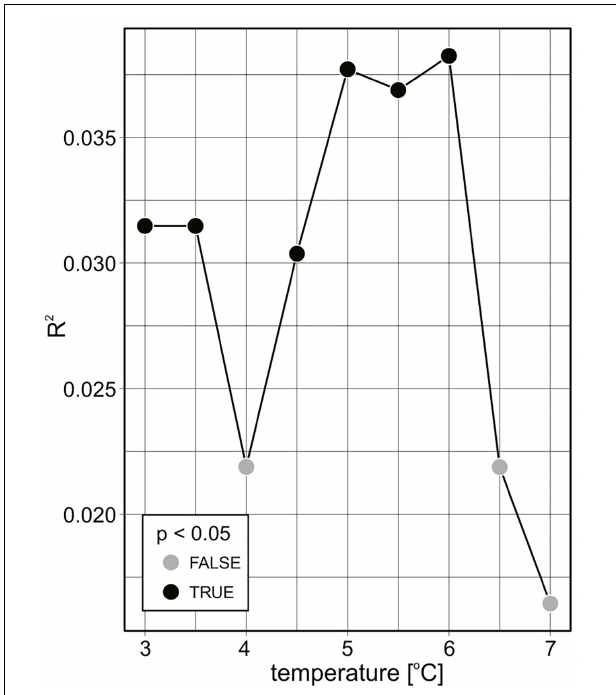
FIGURE 4 | Differences in protist community composition variability (2-year abundance data) in various seawater temperatures [ ◦ C] expressed using NP-MANOVA R 2 and p